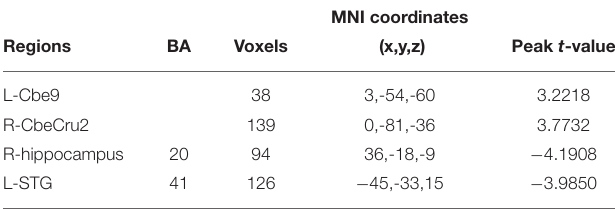
TABLE 4 | Brain regions showing significant differences in fALFF between LBC and non-LBC.